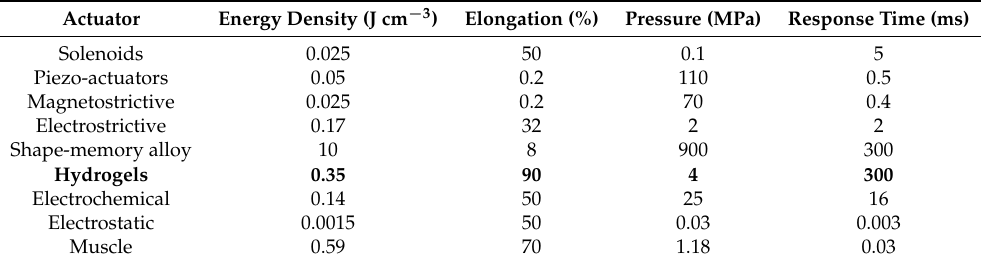
Table 2. Some key comparisons between different types of actuators. Here, we portray a rough estimate of the actuation properties, which may differ in practice with actuator size and heating power. Adapted with permission from [53]. Copyright 2009, Springer.